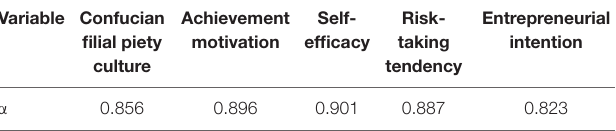
TABLE 1 | variable and measurement items. TABLE 2 | Questionnaire reliability test results.